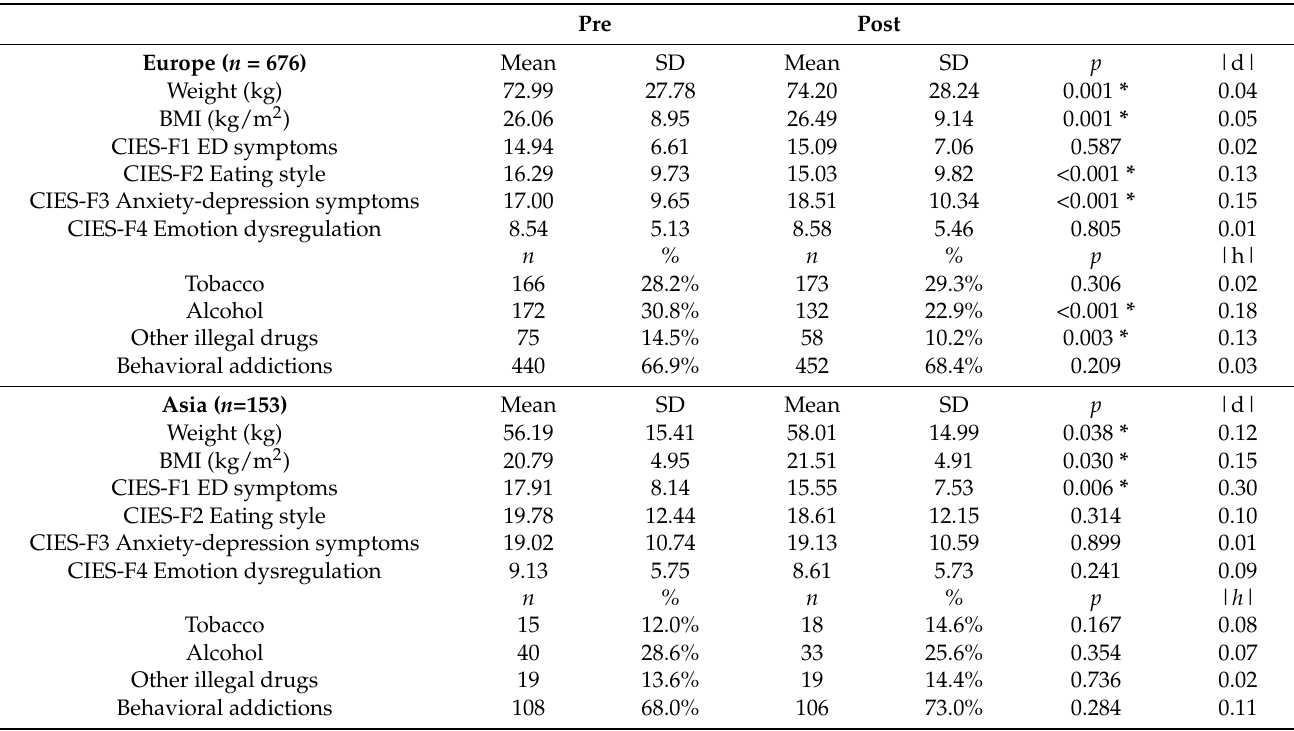
Table 5. Assessment of the post-pre changes stratified by